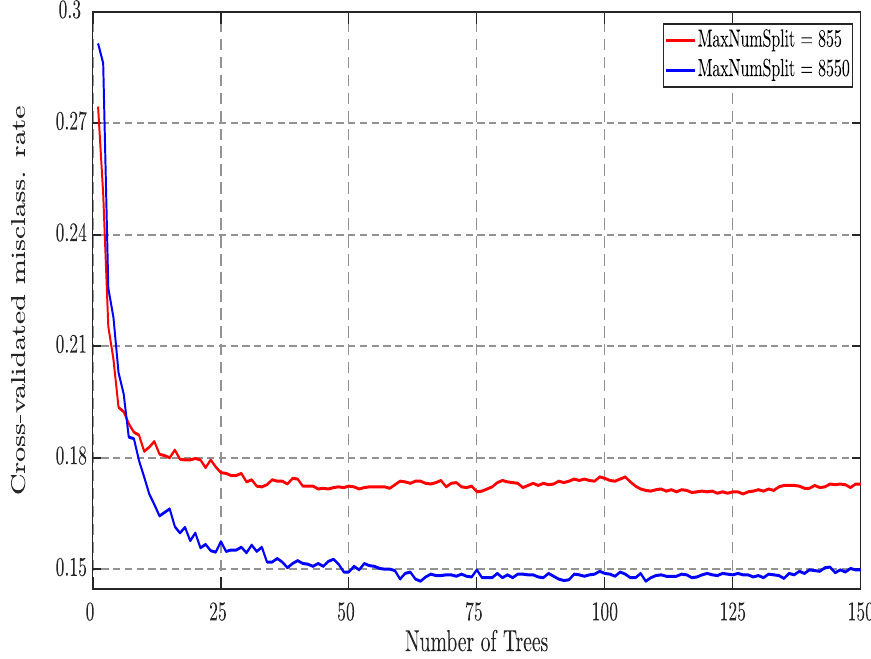
Figure 2. Tuning of hyper parameters of the ensemble of bagged trees (EBT) classifier: Mis- classification error vs. number of